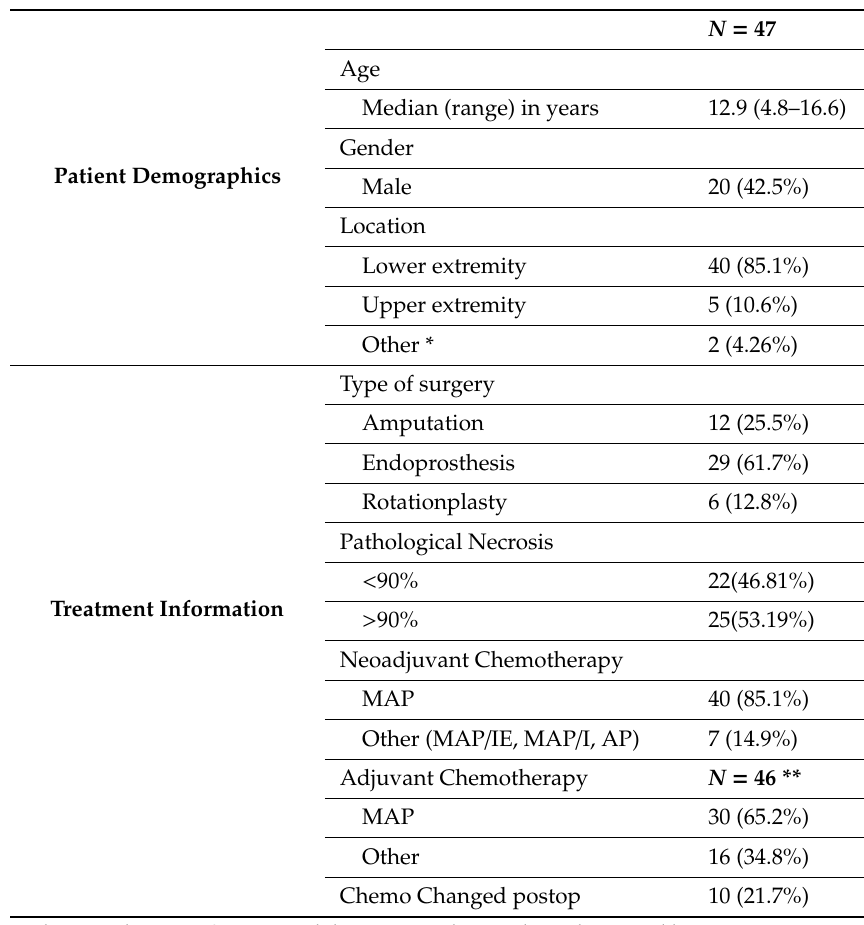
Table 1. Patient characteristics.